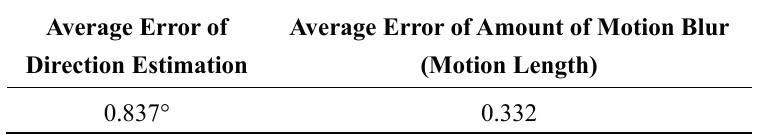
Table 12. Estimation results of motion blur database without our proposed age estimation method.